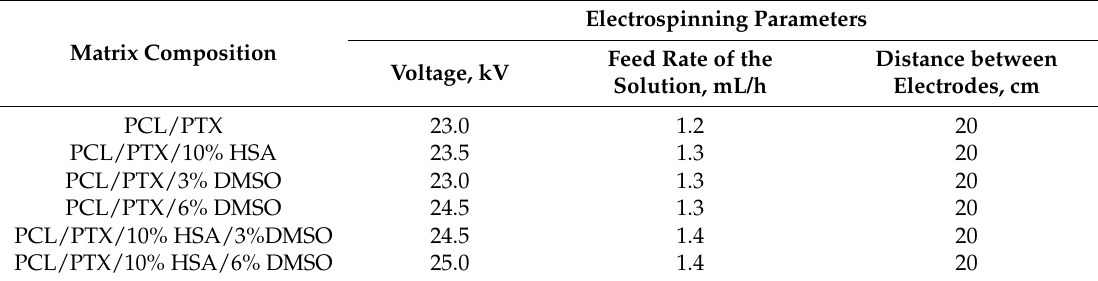
Table 1. Electrospinning conditions for fabrication of 3D